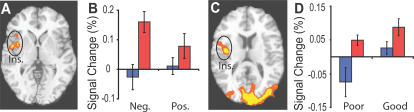
Meditation modulates right insula response to emotional sounds:A. Voxel-wise analysis of the Group by State by Valence (negative versus positive sounds) interaction in insula (Ins.) (z = 2, corrected, colors code: orange, p<5.10ˆ-2, yellow, p<2.10ˆ-2, 15 experts (red) and 15 novices (blue)). B. Average response in Ins. from rest to compassion for experts (red) and novices (blue) for negative and positive sounds. C–D. Voxel-wise analysis of BOLD response to emotional sounds during during poor vs. good blocks of compassion, as verbally reported. C. Main effect for verbal report in insula (Ins.) (z = 13, corrected, colors: orange, p<10ˆ-3, yellow, p<5.10ˆ-4, 12 experts and 10 novices). D. Average response in (Ins.) for experts (red) and novices (blue).